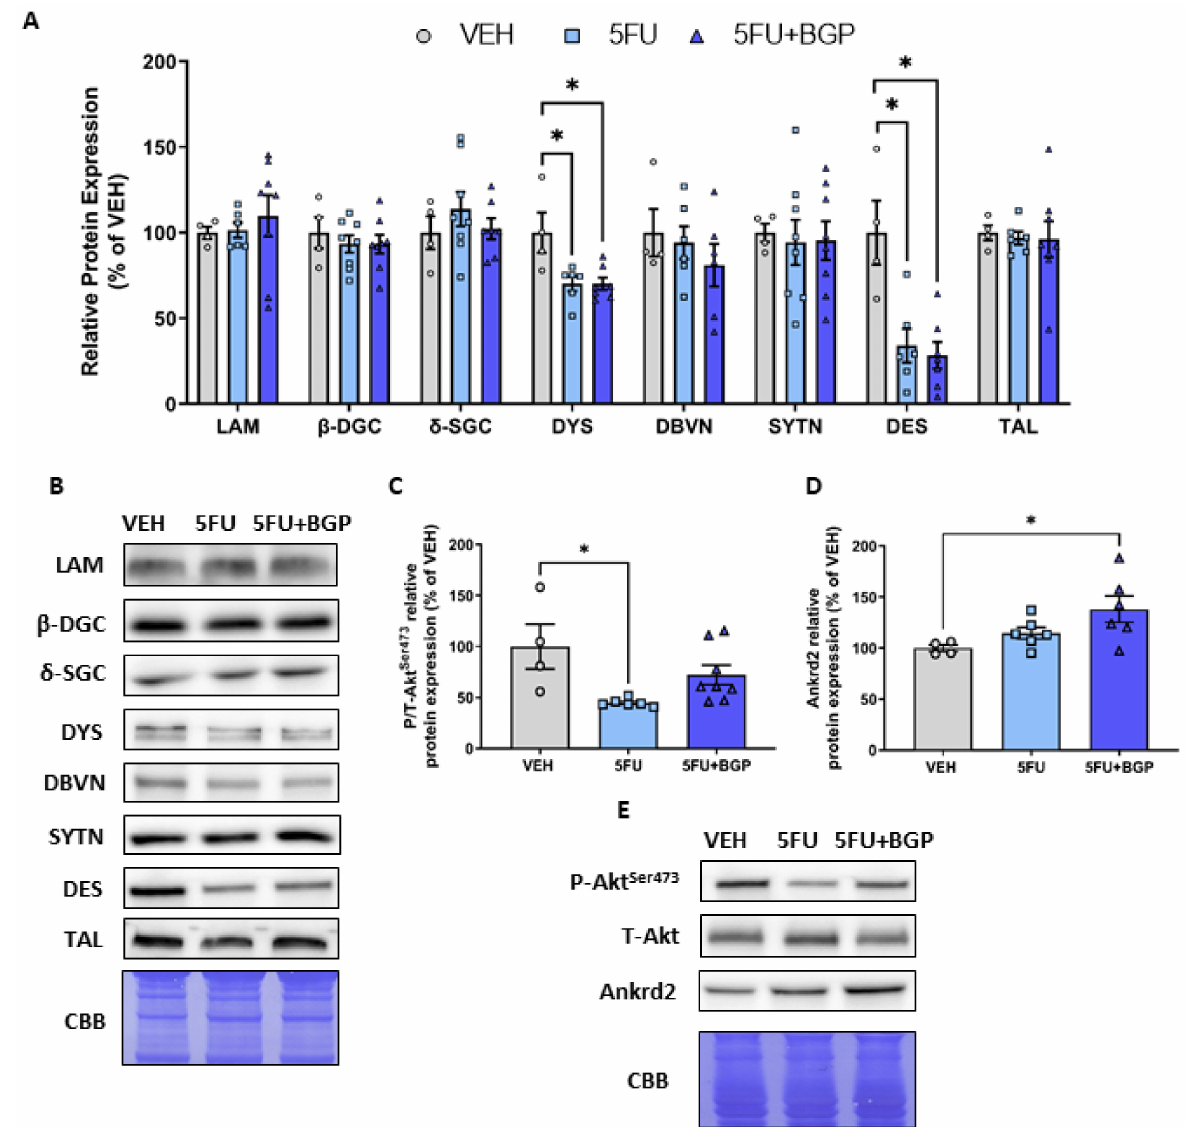
Figure 3. The effect of 5-fluorouracil (5FU) and 5FU with BGP-15 (5FU+BGP) treatment on expression of cytoskeletal structural proteins. Western blotting experiments were undertaken in tibialis anterior (TA) muscle homogenate, with samples probed for ( A , B ) cytoskeletal structural proteins including; laminin (LAM), β -dystroglycan ( β -DGC), δ -sarcoglycan ( δ -SGC), dystrophin (DYS), dystrobrevin (DBVN), syntrophin (SYTN), desmin (DES) and talin (TAL). ( C ) Phosphorylated (Ser473) and total Akt were probed for as an indicator of mammalian target of rapamycin Complex 2 (mTORC2) activity. ( D ) Ankrd2 was probed for as a marker of mechano-sensitvit. ( E ) Representative images for phosphorylated Akt Ser473 , total Akt and Ankrd2 displayed. Protein expression was normalised to total protein derived from Coomassie Brilliant Blue (CBB) staining and presented relative to vehicle (VEH) control group. * = p < 0.05; n = 4 for VEH and n = 6–8 for 5FU and 5FU+BGP groups for Western blotting. Data are mean ±